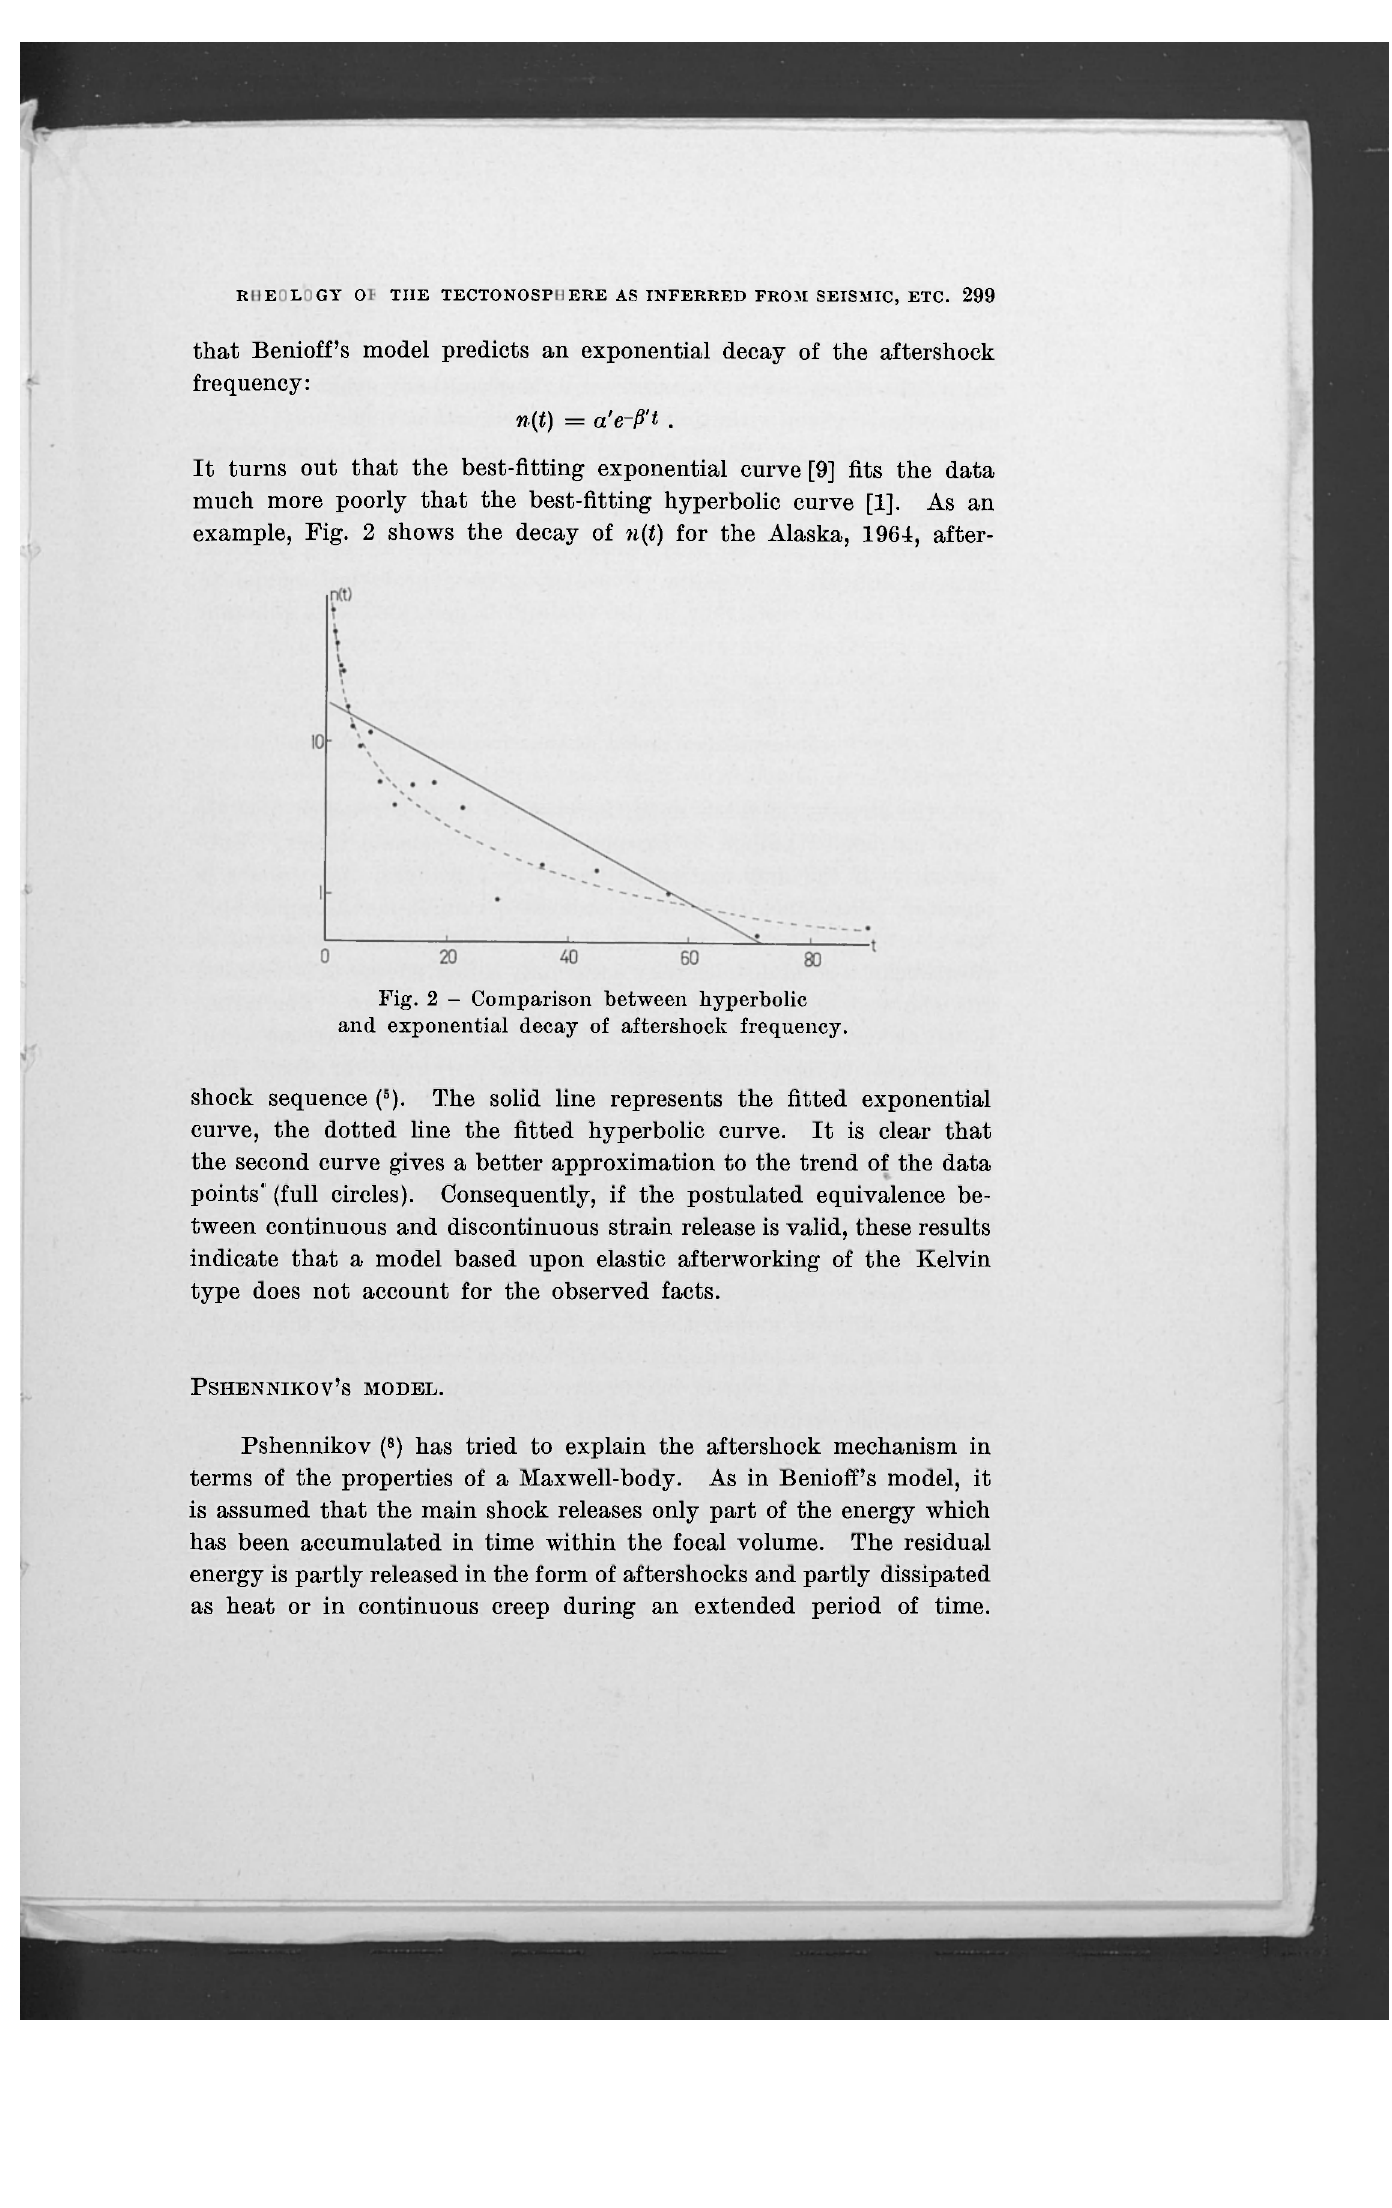
Fig. 2 - Comparison between hyperbolic and exponential decay of aftershock